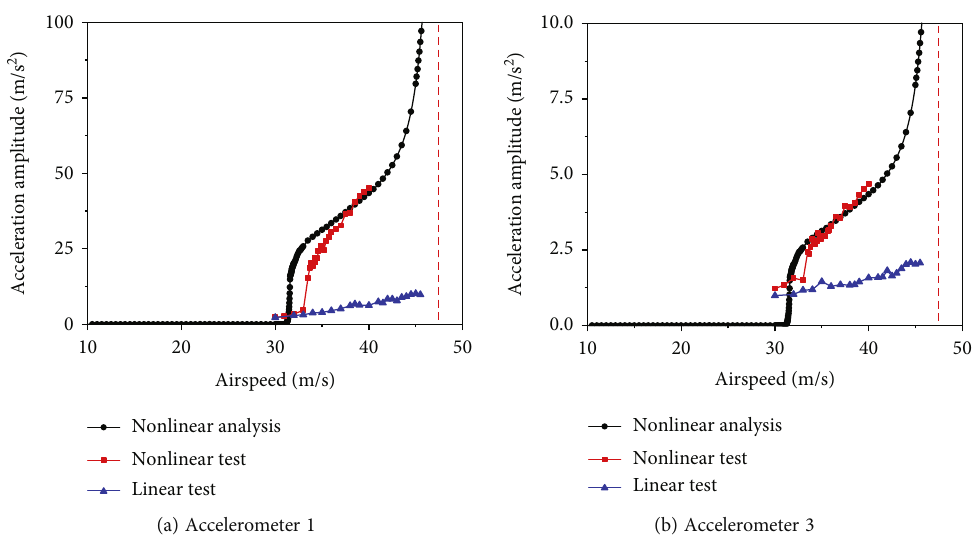
Figure 21: Results of the nonlinear LCO test compared to the numerical